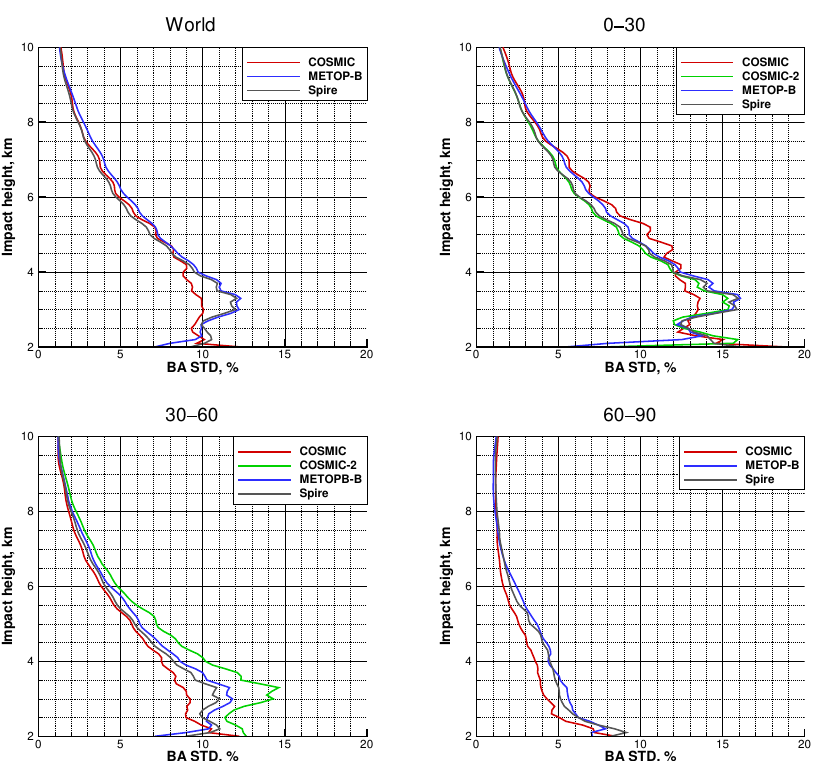
Figure 18. Similar to Figure 17. Standard deviation, dynamic normalization.